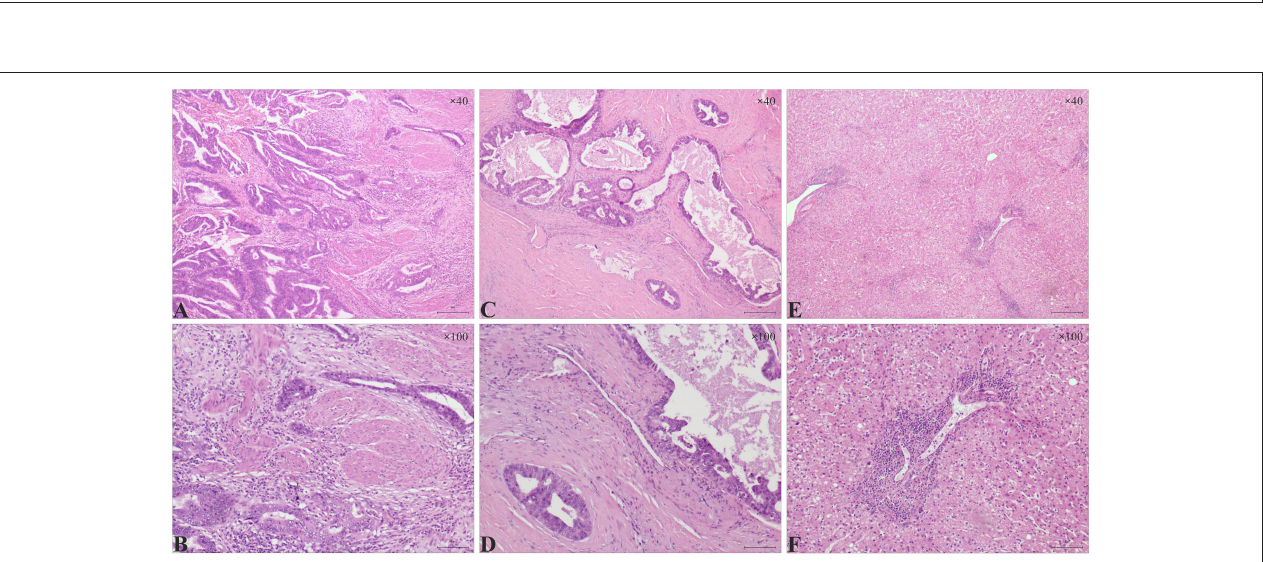
FIGURE 2 | Visualization of the tumor and biliary tree under real-time NIRF imaging. (A,B) Pale green fluorescence detected in the extrahepatic biliary tree (arrow). (C) Green fluorescence accumulated into the gallbladder bed (arrow). (D) Residual green fluorescence observed after wedge liver resection (arrow). (E) Resected gallbladder and liver under the natural light. (F) Dense green fluorescence of the opened gallbladder under the NIFR imaging.